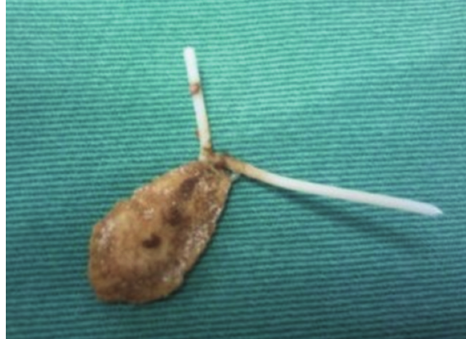
Figure 3: Intrauterine device extracted endoscopically, demonstrat- ing partial stone